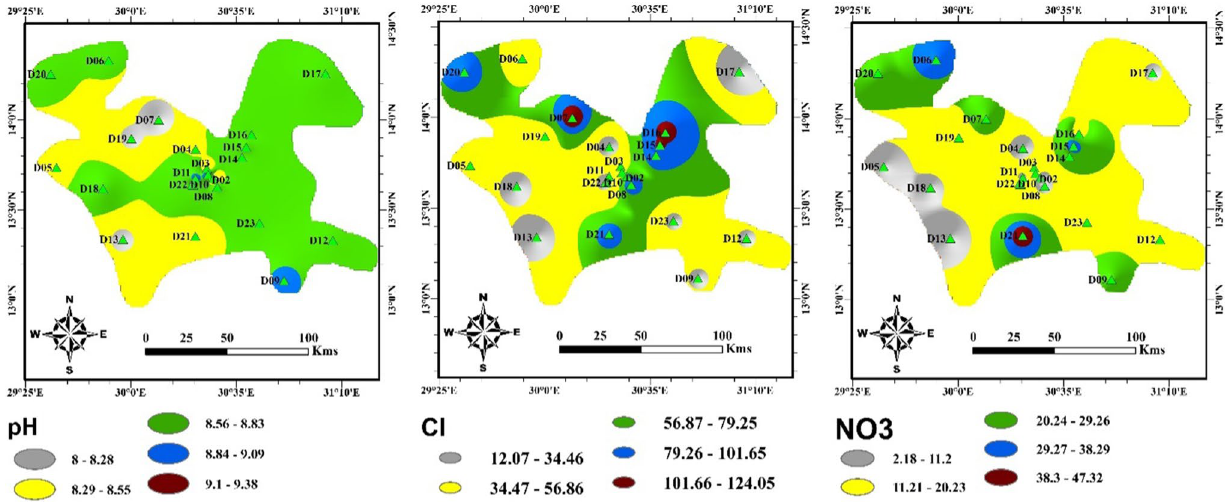
Fig. 6 Spatial distribution of GIS interpolation maps of the pH, Cl, and NO